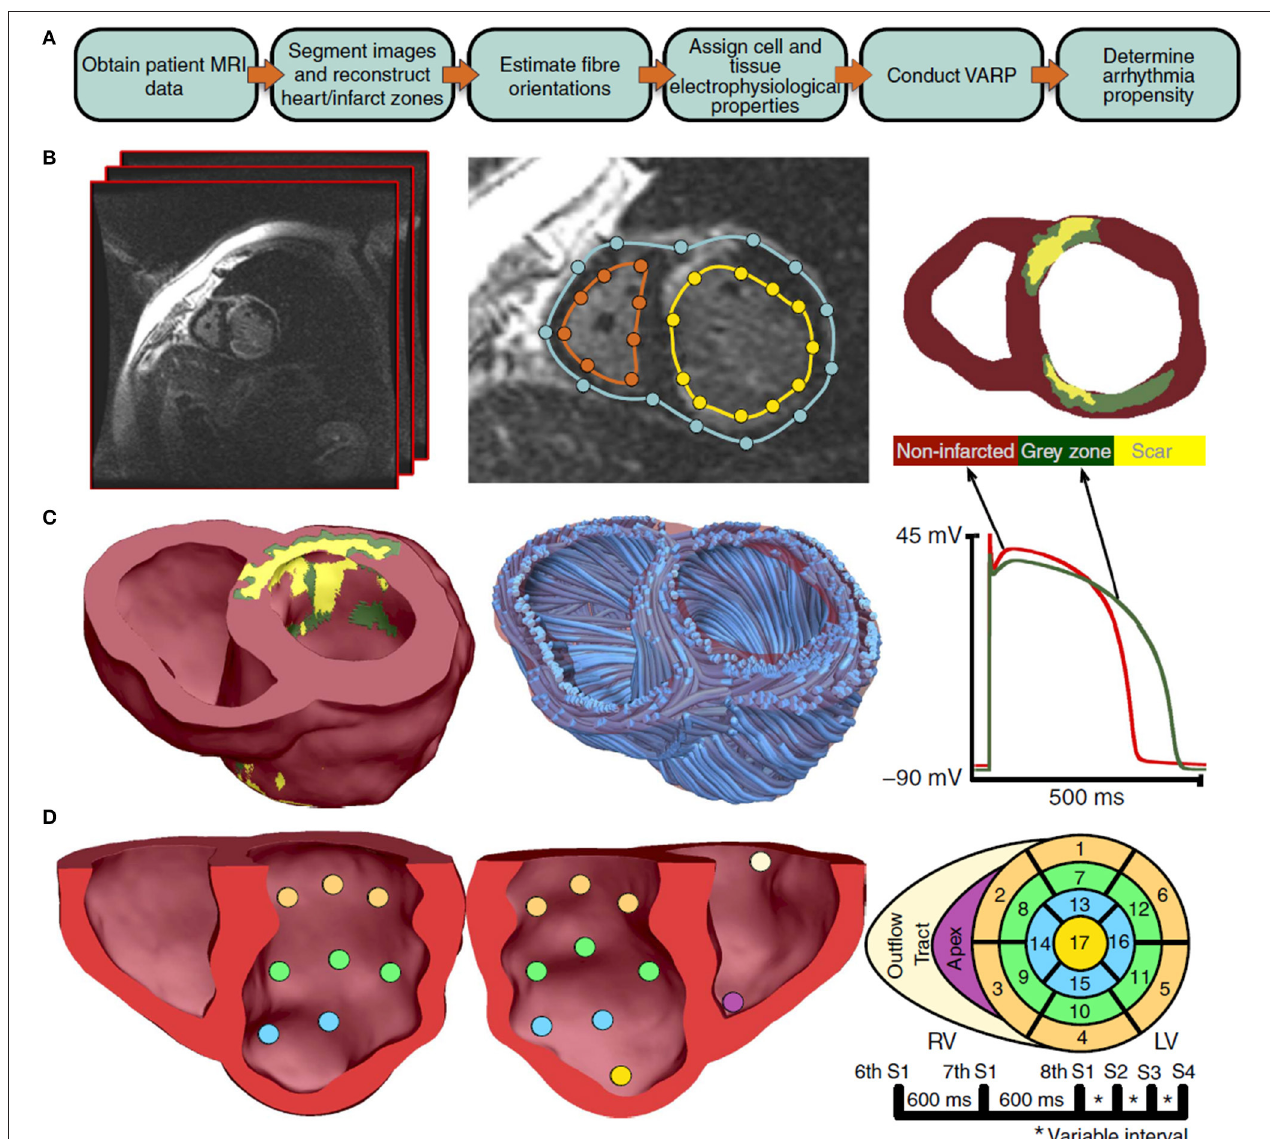
FIGURE 5 | Overview of process used to predict sudden cardiac death risk in Arevalo et al. (2016). A flowchart of the pipeline is shown in sub-figure (A) . MR images are segmented [sub-figure (B) ] to develop a patient-specific computational model which includes regions of scar tissue and border zone (“gray zone”) [sub-figure (C) ]. A rule-based approach is used to specify fiber directions. The model is paced from 19 sites [sub-figure (D) ] and with various pacing protocols and assessed for whether ventricular tachycardia is inducible. (Reproduced from Arevalo et al., 2016 with permission under Creative Commons